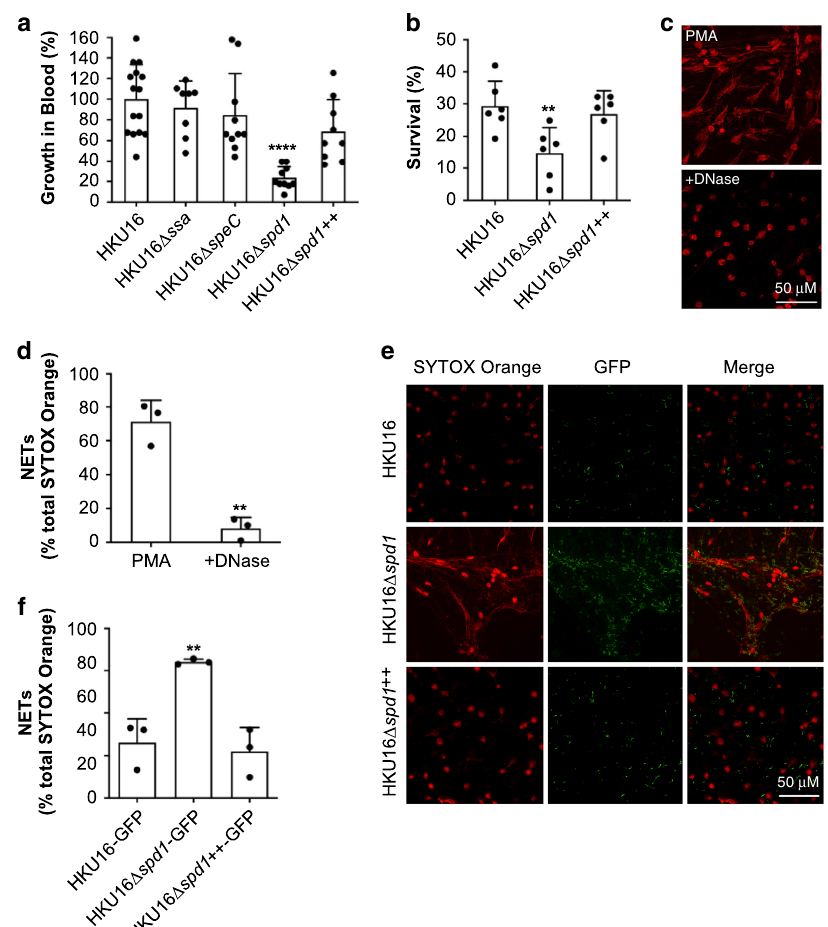
Fig. 3 The Φ HKU.vir-encoded DNase Spd1 promotes resistance to neutrophil killing. a Growth of indicated HKU16 strains in whole human blood. Statistical signi fi cance was assessed using one-way ANOVA with Dunnett ’ s multiple comparisons post hoc test against the HKU16 control group (**** p < 0.0001 for HKU16 Δ spd 1). b Human neutrophil killing assay. The data represent the mean ± SEM of six independent experiments. Statistical signi fi